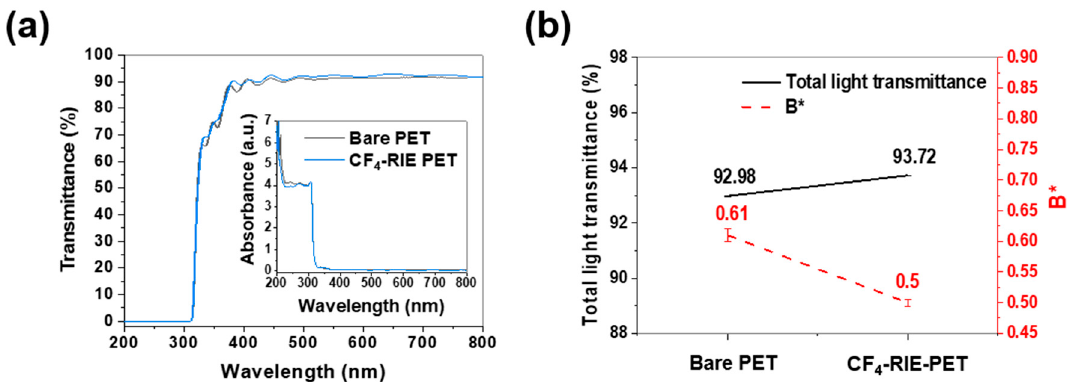
Figure 1. Optical characteristics of bare polyethylene terephthalate film (bare PET) and plasma-treated PET film (CF 4 -RIE PET); ( a ) transmittance and absorbance and ( b ) total light transmittance and B* (yellow-blue level).